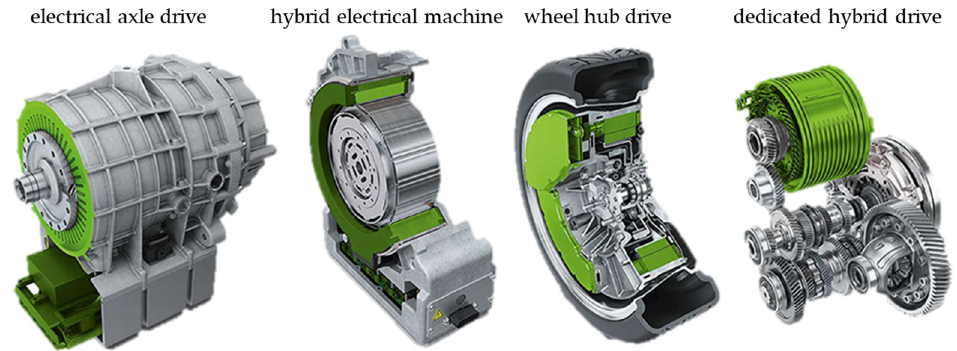
Figure 3. Electrical machines for different applications in full electrical vehicles and hybrid electrical vehicles [19]. vehicles